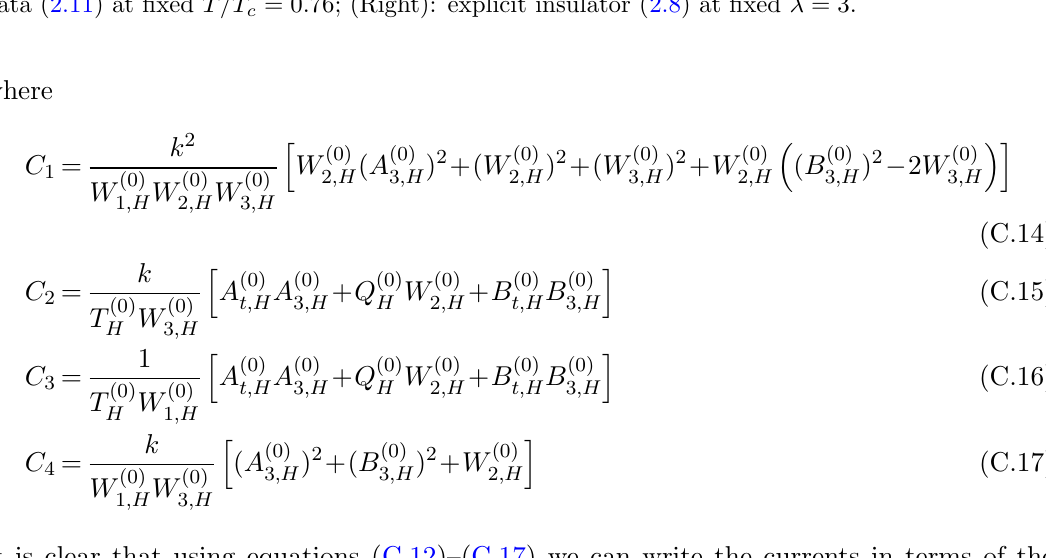
Figure 15 . Percentage di(cid:11)erence between DC calculation from horizon data and AC calculation at ! = 10 (cid:0) 8 . (Left): pinned spontaneous data (2.11) at (cid:12)xed (cid:21) = 0 : 1; (Center): pinned spontaneous data (2.11) at (cid:12)xed T=T c = 0 : 76; (Right): explicit insulator (2.8) at (cid:12)xed (cid:21) =